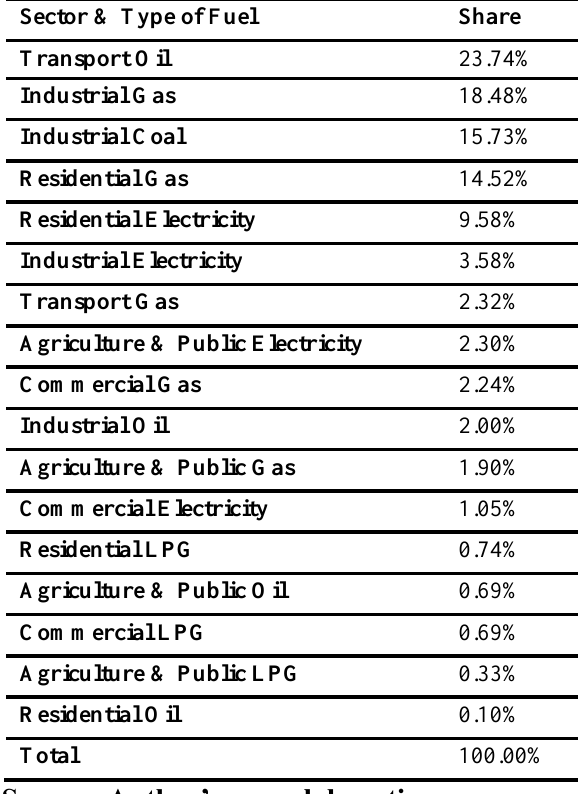
Table.7.Shares of Sectoral Demand for Final Energy by Type of Fuel (2019)